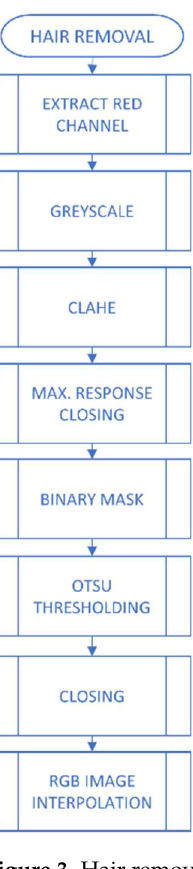
Figure 2. Marker cutout.